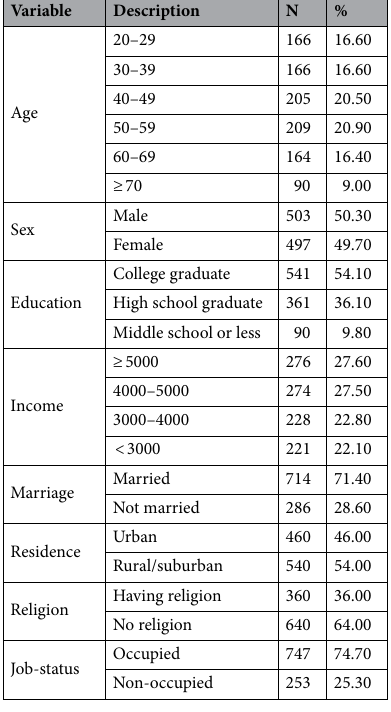
Table 1. Participants’ sociodemographic